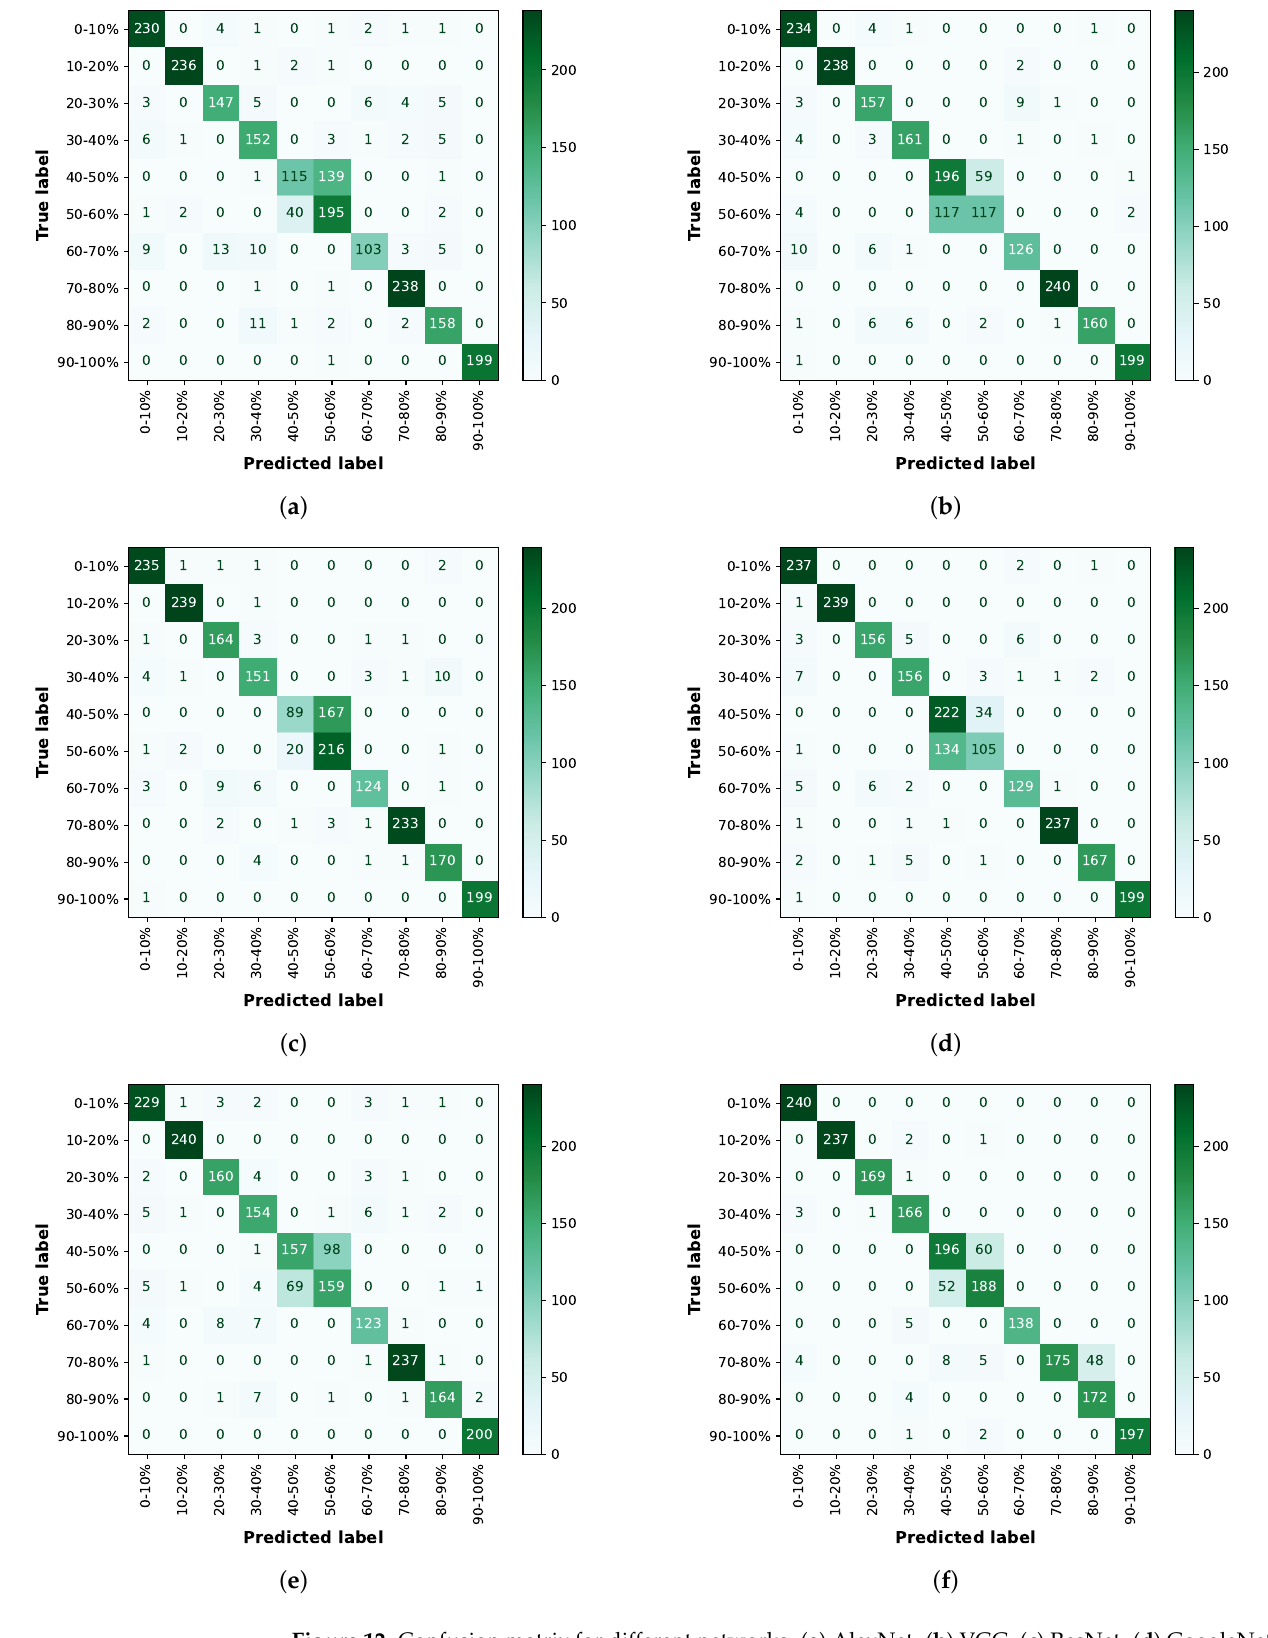
Figure 12. Confusion matrix for different networks. ( a ) AlexNet. ( b ) VGG. ( c ) ResNet. ( d ) GoogleNet. ( e ) MobileNet. ( f )